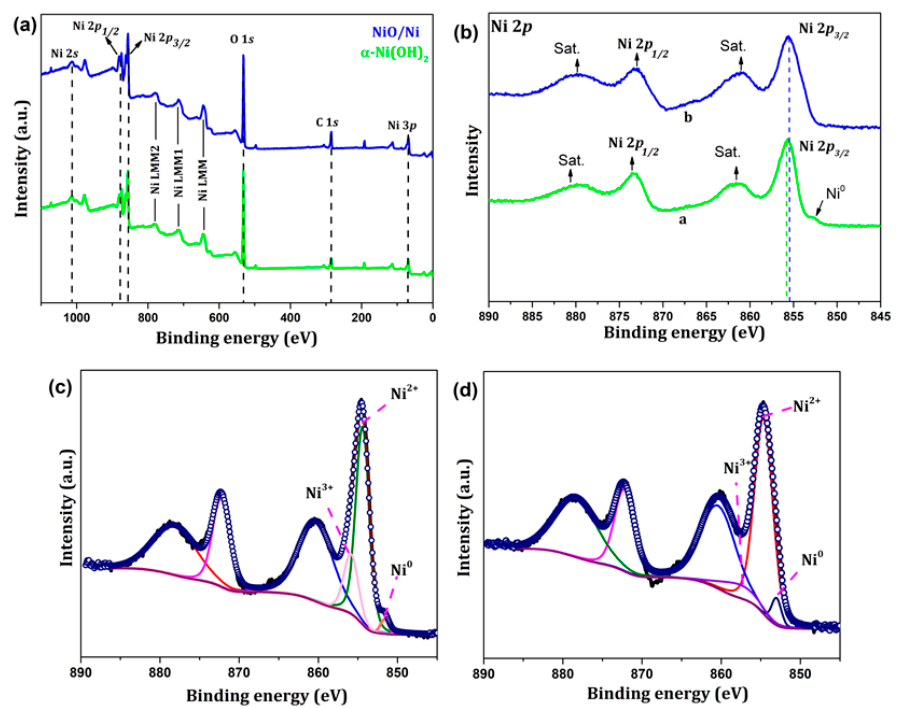
Figure 4. XPS spectra of the ( a ) α -Ni(OH) 2 and ( b ) NiO/Ni aerogel samples, and the deconvoluted spectra ( c , d ) of the Ni 2p 3/2 and Ni 2p 1/2 peaks.